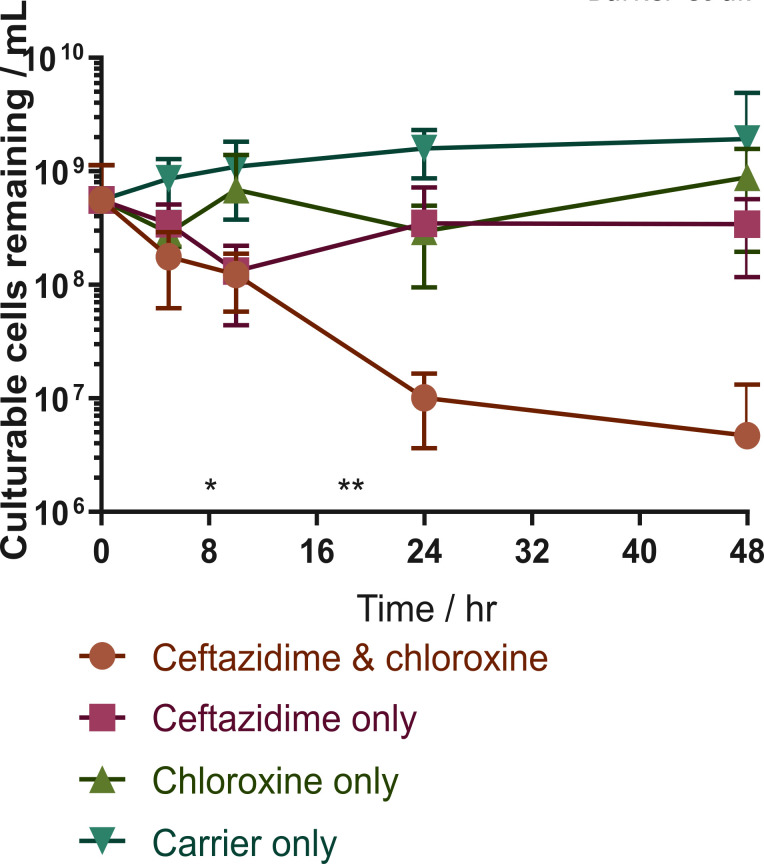
A secondary assay evaluating the number of culturable cells remaining following treatment with ceftazidime and chloroxine.A culture of B. thailandensis was treated with 730 μM ceftazidime hydrate, 30 μM chloroxine, both, or neither. Samples were incubated at 37°C with shaking. Samples were taken at time intervals, cells harvested and resuspended in LB broth before serial dilution and enumerating on agar. Error indicates standard error of serial dilution and CFU count. n = 6. Differences between the ceftazidime alone, chloroxine alone, and ceftazidime and chloroxine samples were analyzed using a Kruskal-Wallis test with Dunn post-hoc comparison using Graphpad v. 7.03. *—p < 0.01 between chloroxine alone, and ceftazidime with chloroxine. **—p < 0.05 between both chloroxine alone and ceftazidime alone, and both compounds.